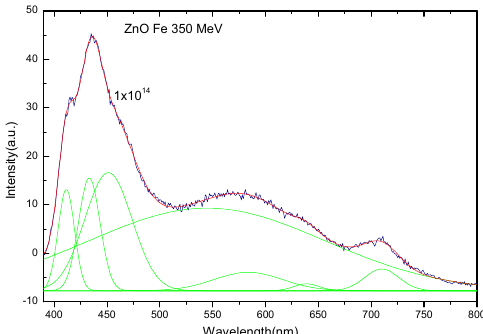
Figure 5. PL spectra of ZnO irradiated with 1 × 10 13 ions/cm 256 Fe 21+ ions. Experimental data (black line)